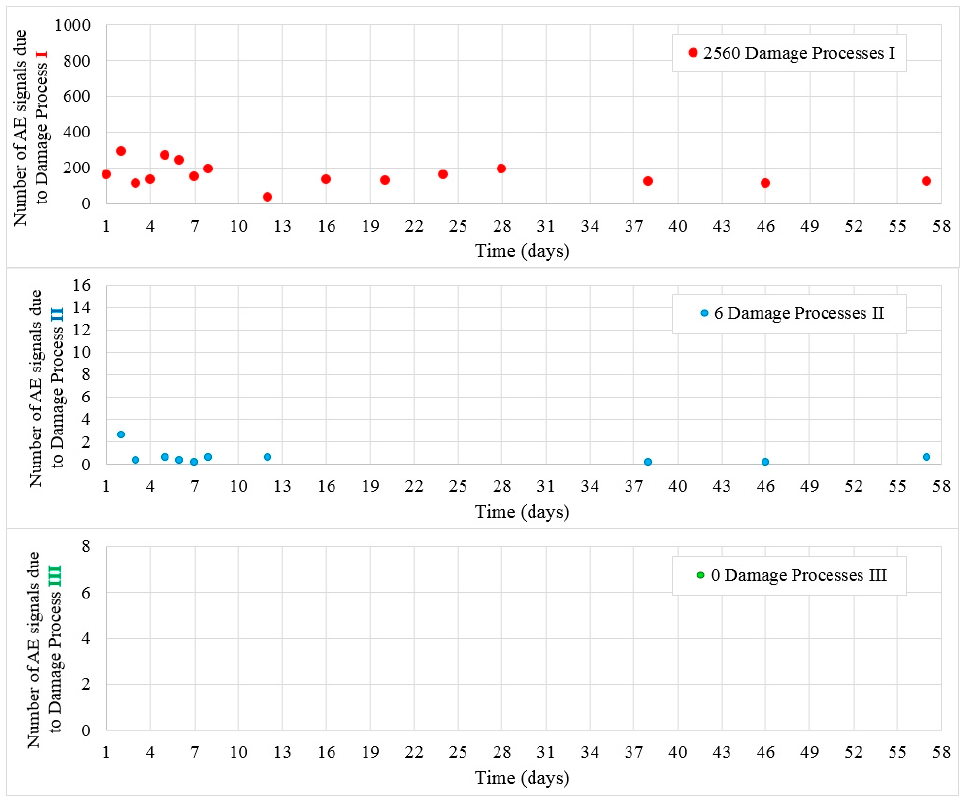
Figure 9. Number of damage processes I–III obtained from W6 samples.